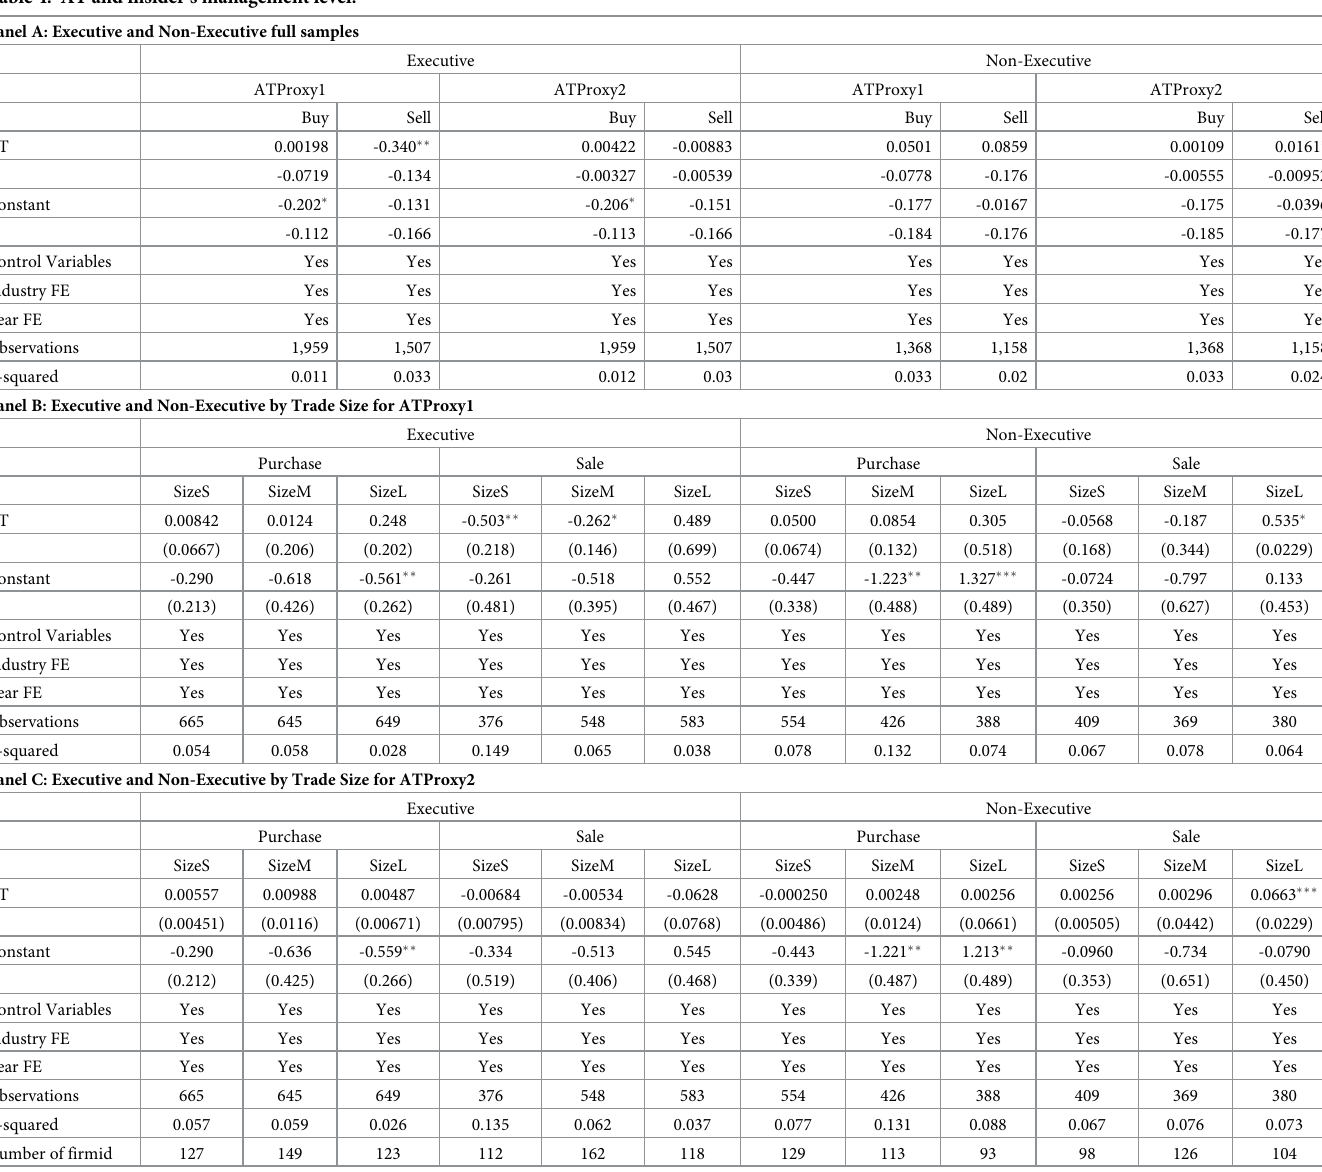
Table 4. AT and insider’s management